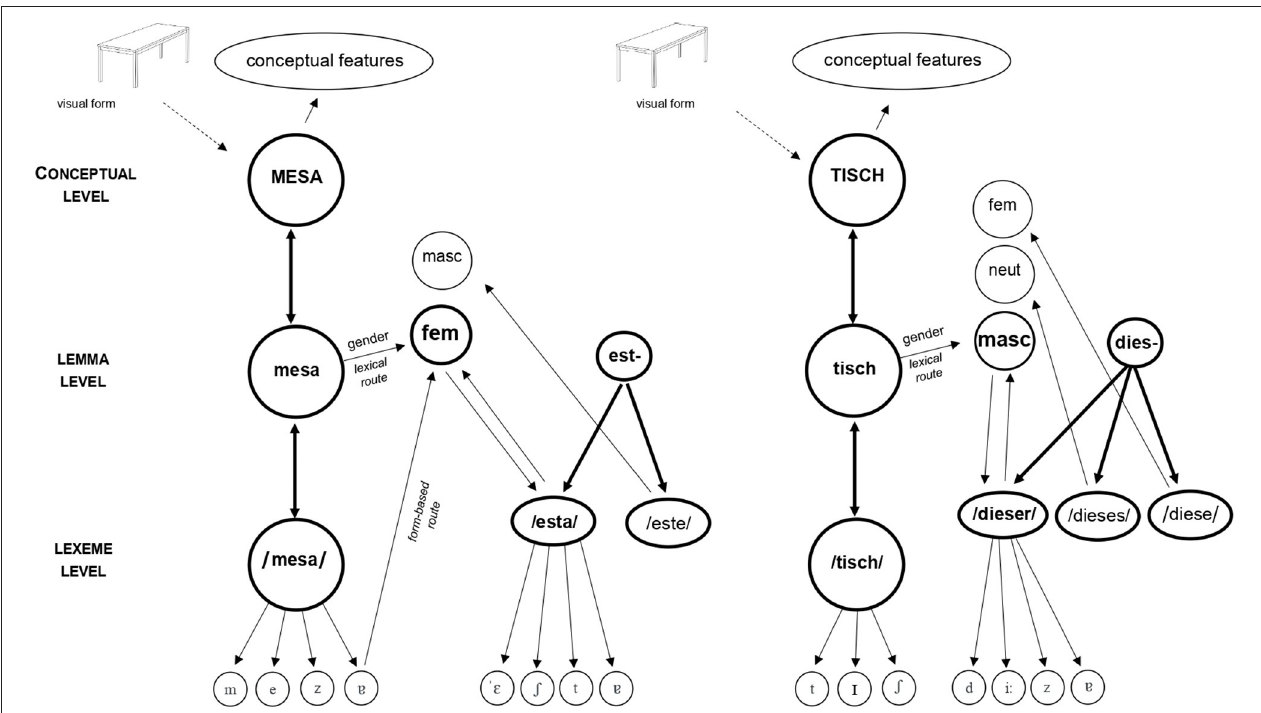
FIGURE 1 | Lexical network (simplified) proposed by the GAP hypothesis. Representation of the spoken production of the noun phrase “this table” in Portuguese “ esta mesa ” (feminine; on the left) and in German “ dieser Tisch ” (nominative case, masculine; on the right). Gender values are represented through gender nodes that accumulate activation. Bidirectional connections and cascaded flow of information is conceived as in Dell’s model. The form-based and lexical routes from the Dual Route model of gender retrieval (Gollan and Frost, 2001) of language comprehension are adapted to language production (Sá-Leite et al., 2021). For more information on the differential processing of transparent and opaque nouns, see Sá-Leite et al.